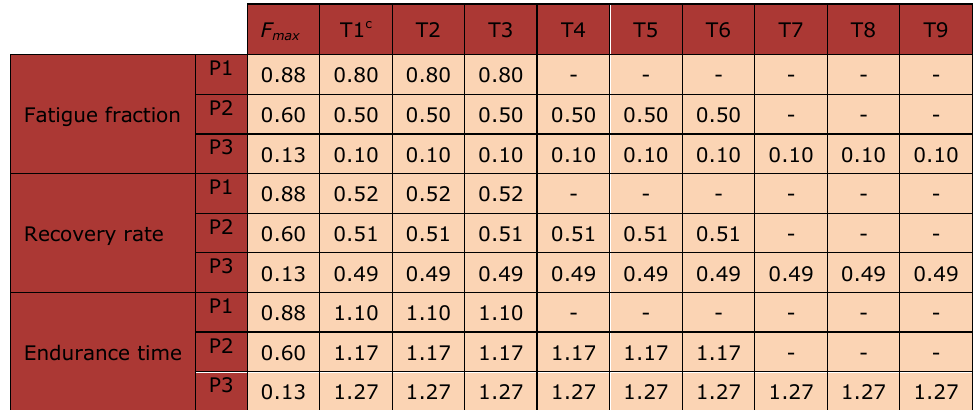
Table 7. Fatigue Levels and Recovery